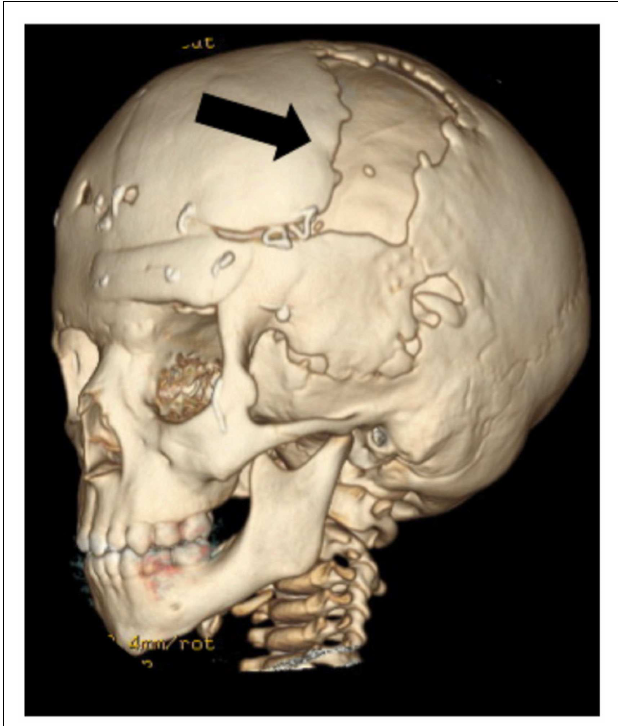
reconstruction with alloplastic materials or large bone